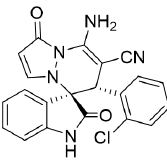
Molecules 2023 , 28 ,